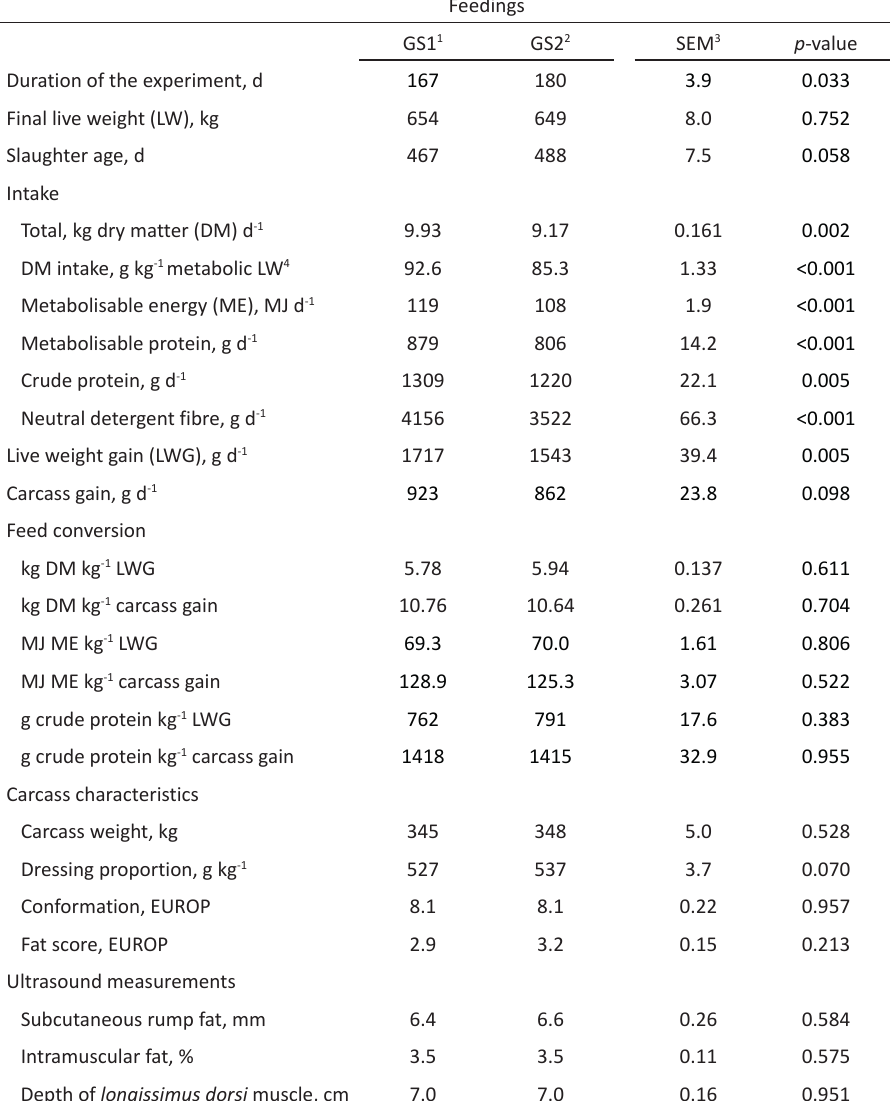
Table 4. Intake, growth, feed conversion and carcass traits of the bulls fed different rations.